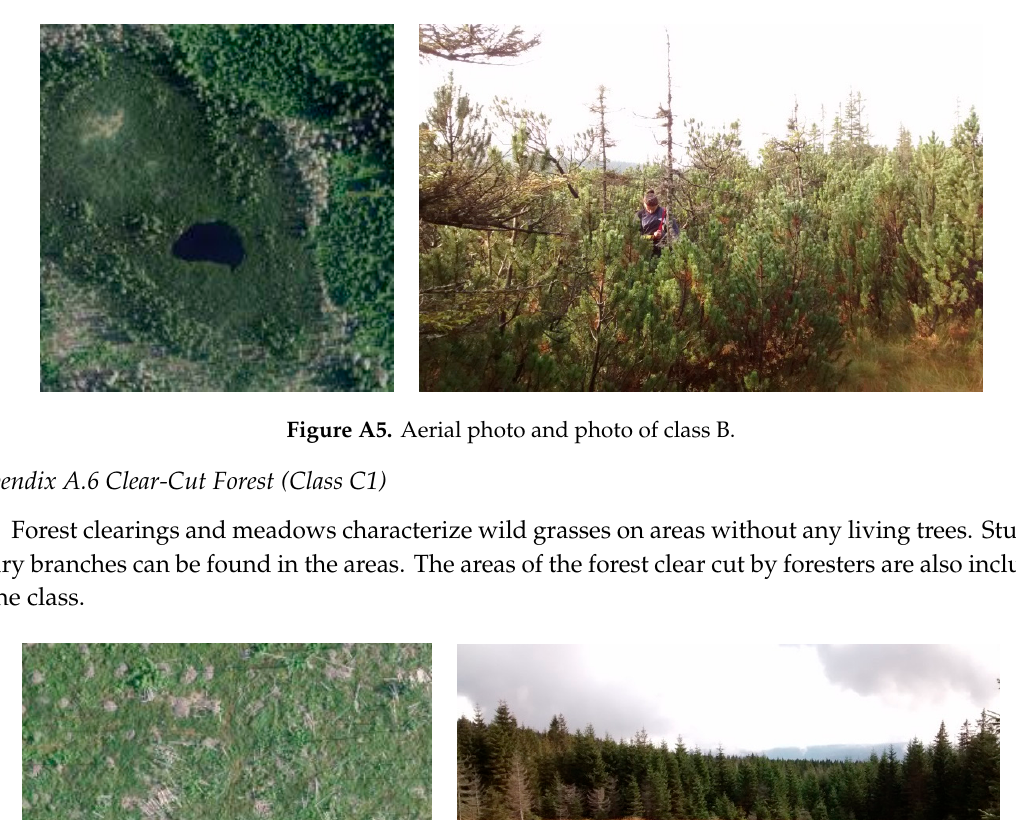
Figure A7. Aerial photo and photo of class C2. Appendix A.8. Water Bodies (Class E) This category includes larger streams and watercourses in the image areas. Above all, it is the Roklanský stream or the Vydra and the small lakes. The category also includes shadows appearing on the image, due to similar spectral characteristics. Figure A8. Aerial photo and photo of class E.